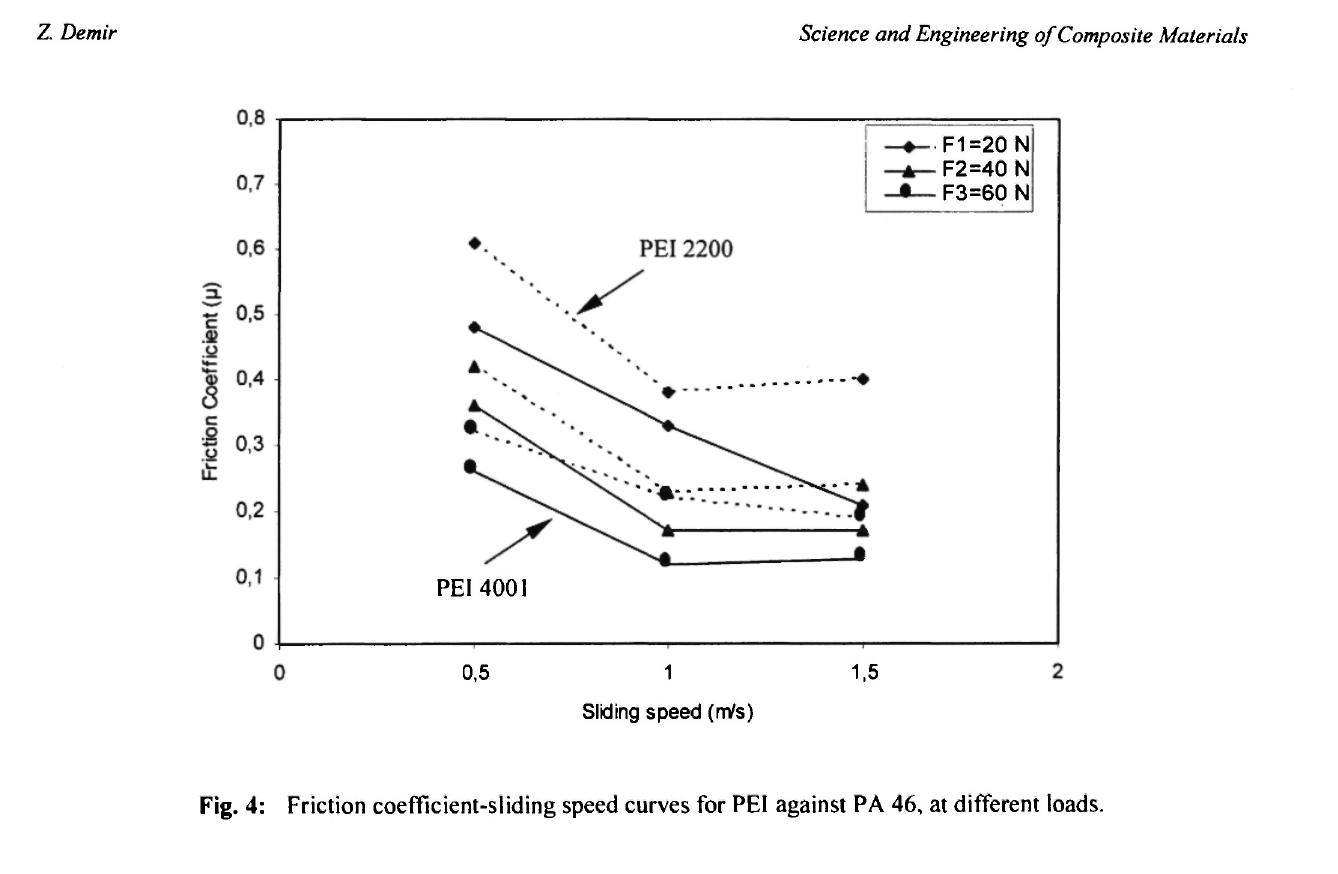
Fig. 4: Friction coefficient-sliding speed curves for PEI against PA 46, at different loads.